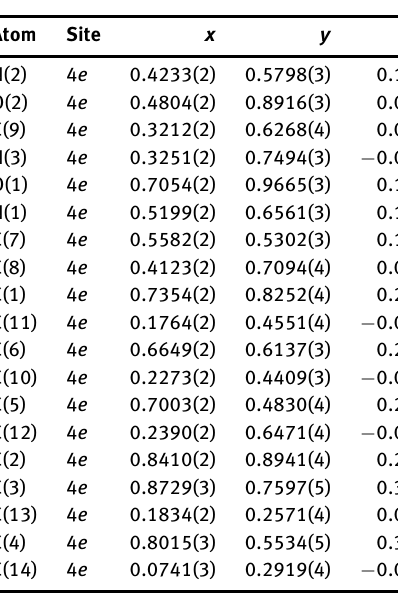
Table 3: Atomic displacement parameters (Å 2